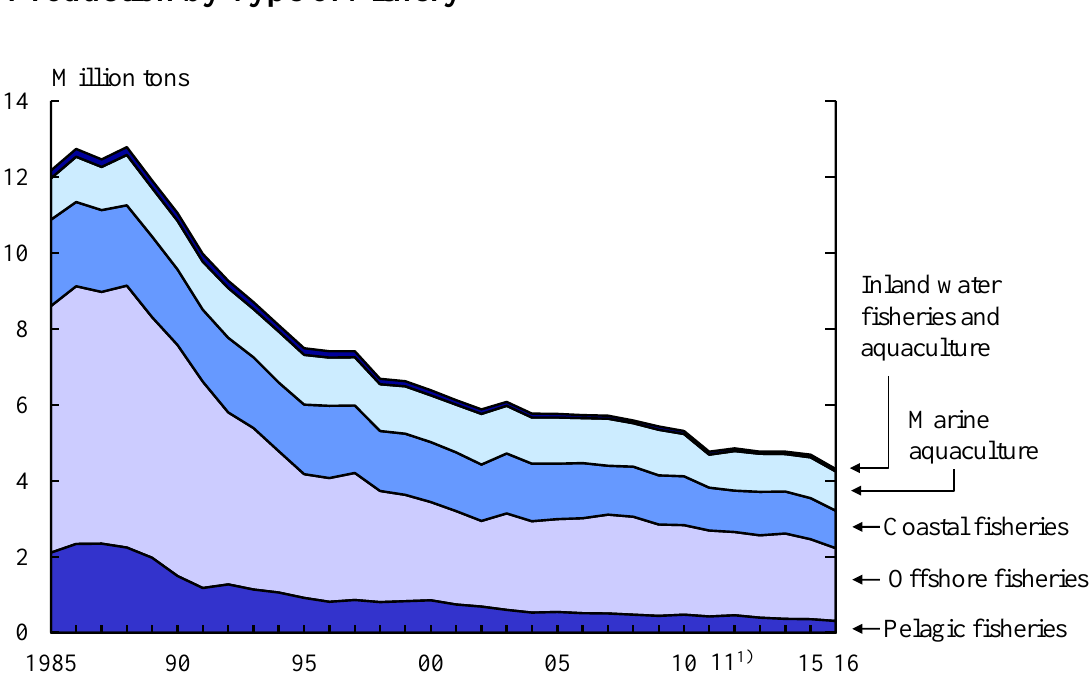
Production by Type of